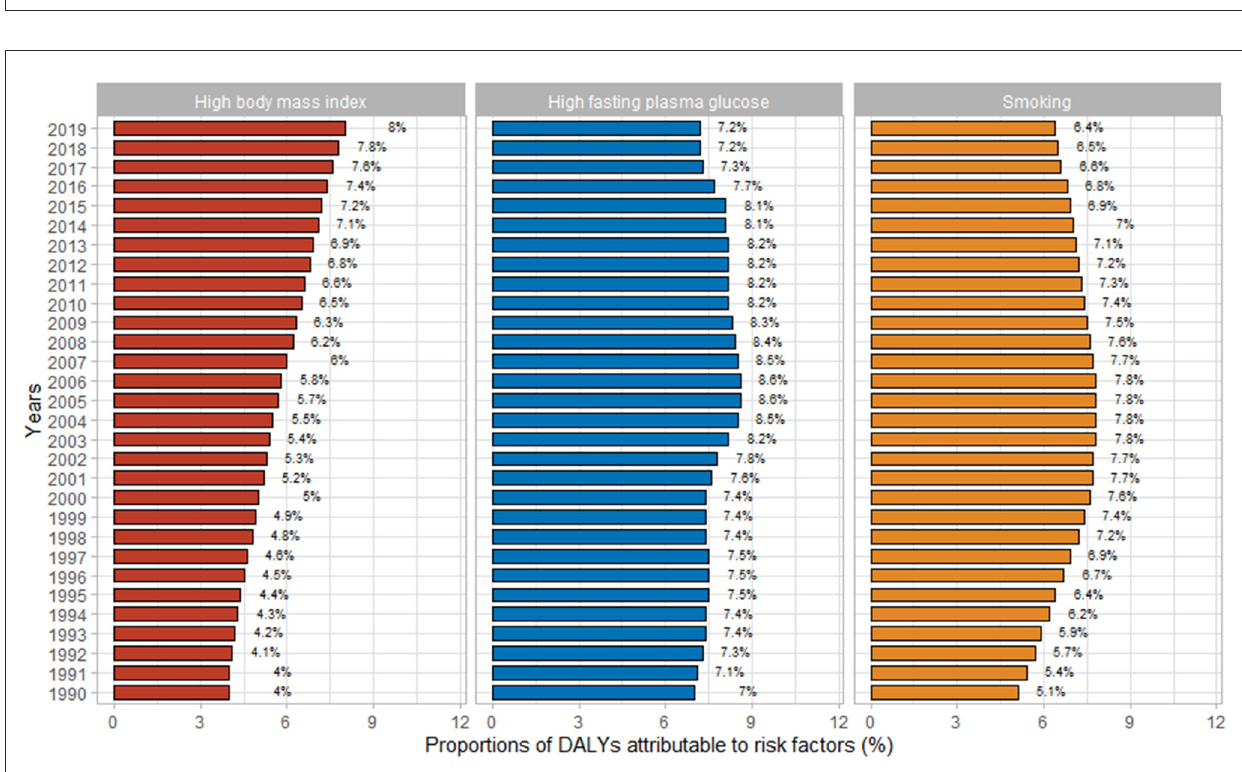
reference line, while the number of deaths is slightly below the reference line. Owing to the large female population in China, the projected numbers of CFWD and deaths from dementia are high and the outlook is not